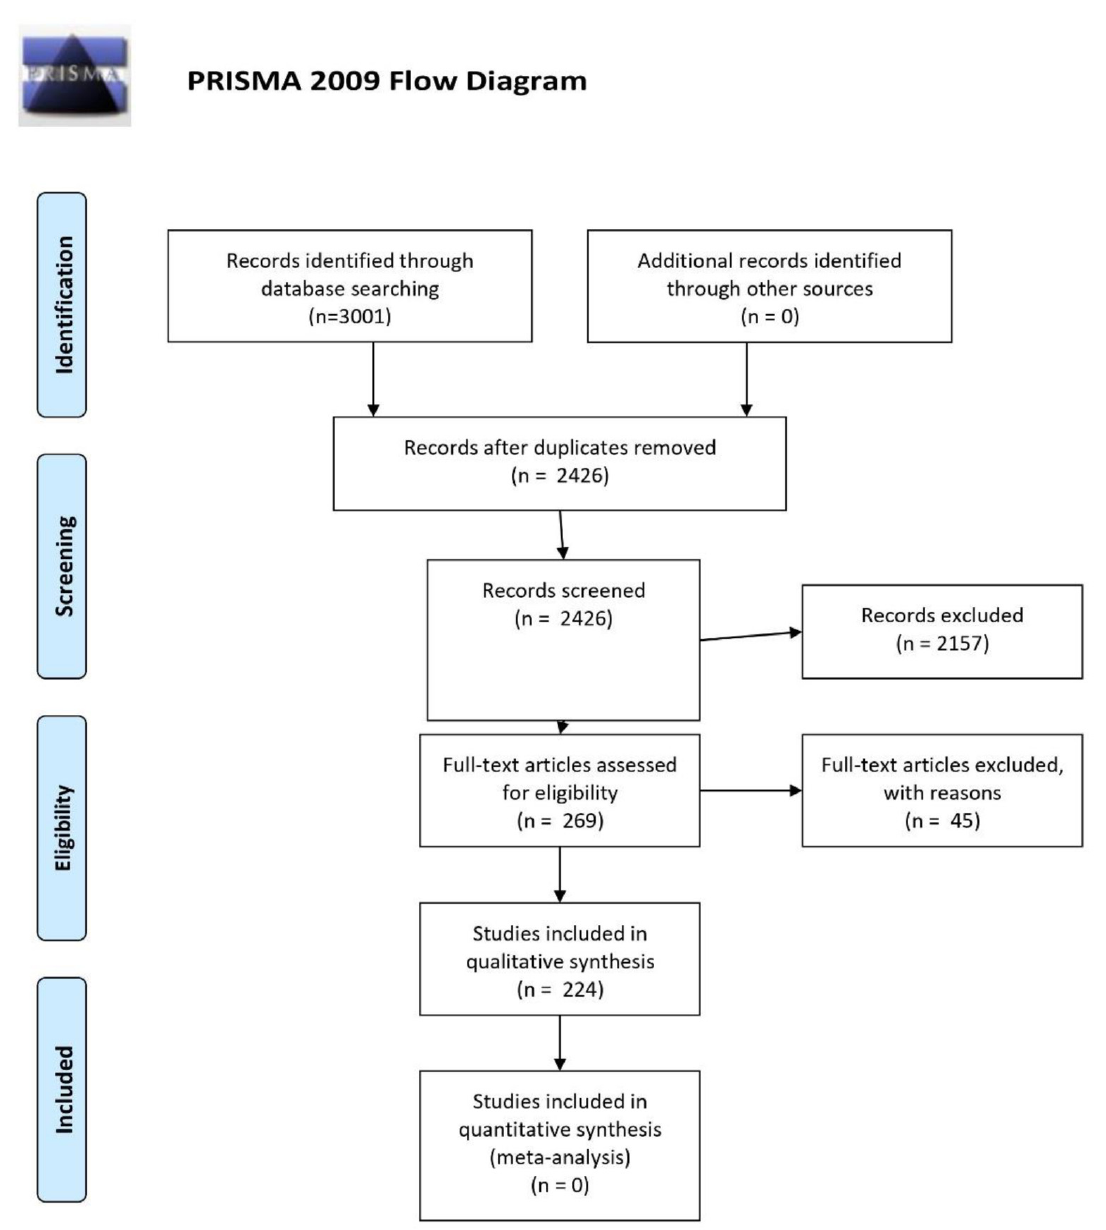
Figure 1. PRISMA Flow Diagram of study identification, screening, eligibility, and inclusion in final review